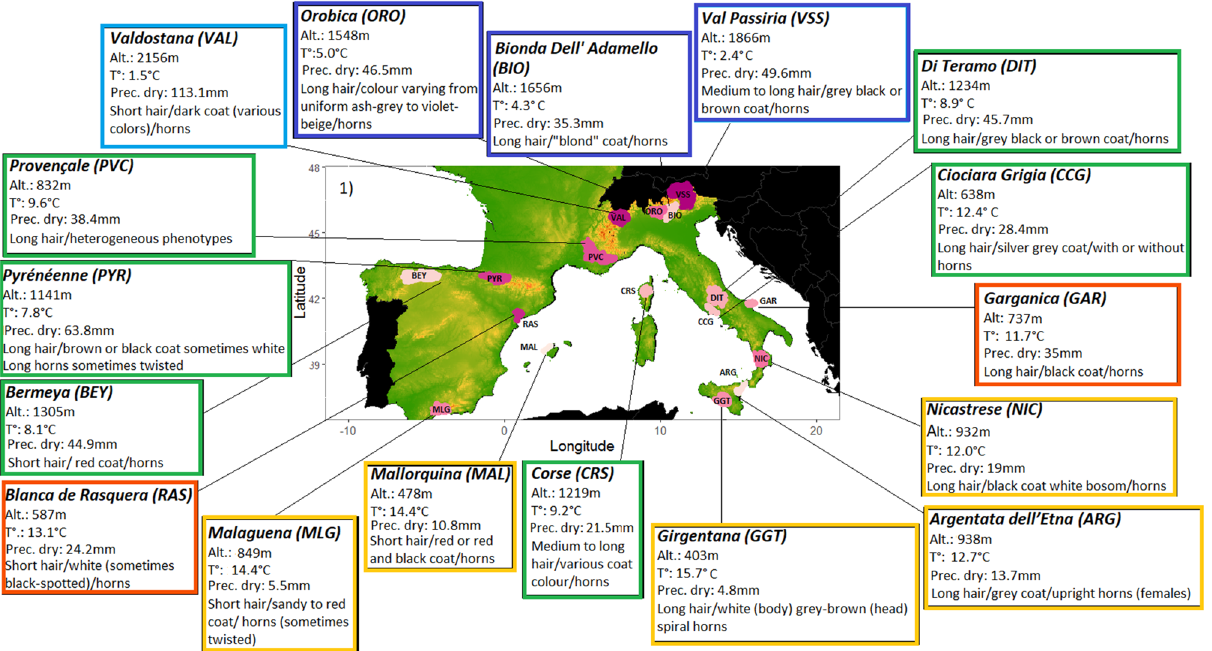
Figure 1. Description of goat cradles as a function of environmental variables: synthetic descriptions of cradles and some characteristic breed phenotypic traits. The breed labels are color coded according to the clustering ranking defined by the PCA/HCPC analysis shown in Fig.